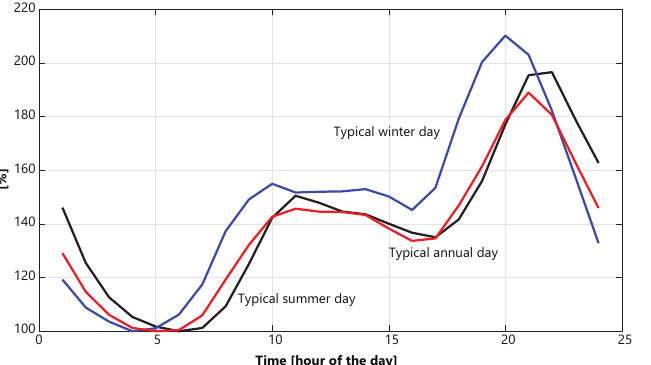
Figure 4. Daily load curves for a typical day in summer (black), winter (blue), and for the whole year (red), in terms of the daily